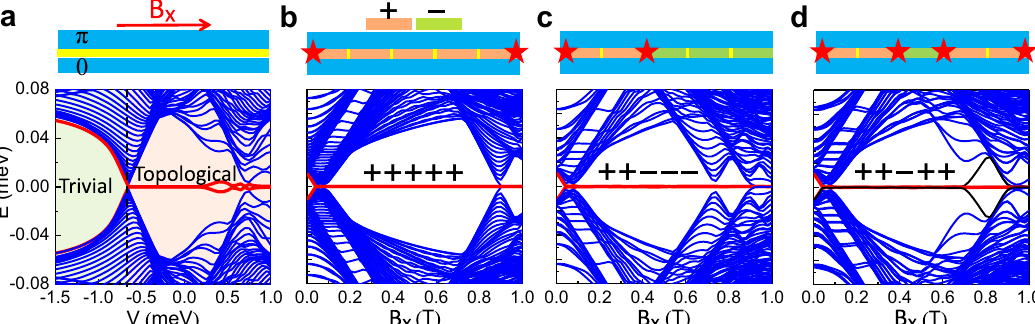
Fig. 4 Mini-gate controlled topological transitions and MBS in an SJ. a Schematic (top) and energy spectra (bottom) for a planar π -SJ at B x = 0.6 T as a function of the gate voltage ( V = μ N − μ S ), tuned by the top gate (not shown), which covers the whole N region. The black dashed line indicates the critical gate voltage between the trivial region (green) and topological region (orange). b – d Schematic (top) of a planar π -SJ with MBS (stars) for + + + + + , + + − − − , and + + − + + mini-gate con fi gurations and the corresponding energy spectra (bottom), where V − = − 1 meV and V + = 0 meV are taken for − and + states, respectively. Red and black lines: evolution of fi nite-energy states into MBS inside the topological gap. The parameters are speci fi ed in the main